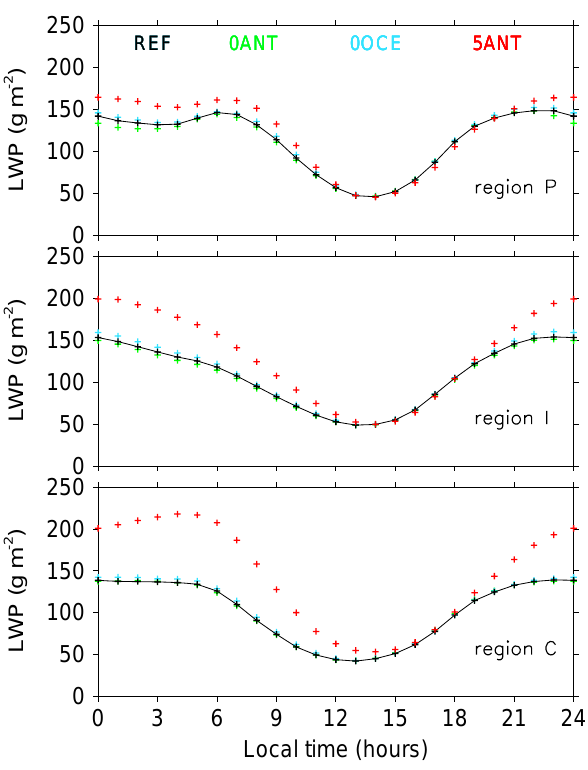
Fig. 5. Simulation period mean diurnal cycles of LWP in the ref- erence simulation (REF, black solid line) and in the 3 sensitiv- ity simulations with regional anthropogenic emissions turned off (0ANT, green cross), with regional oceanic emissions turned off (0OCE, blue cross), and with scaled regional anthropogenic emis- sions (5ANT, red cross), respectively, for regions P (top), I (middle), and C